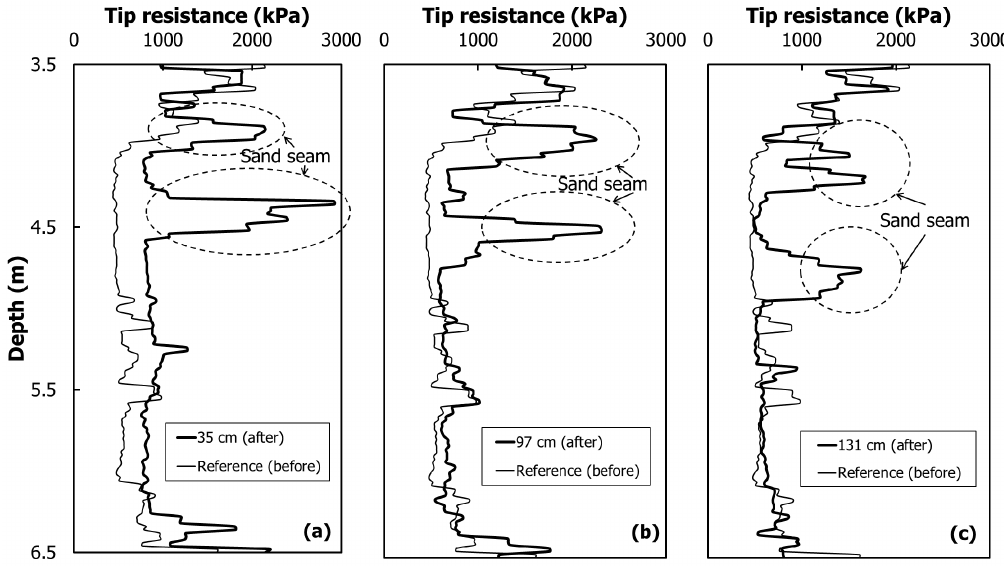
Figure 11. The variation of the tip resistance due to ground heating using an electric heat pipe (Case 4), ( a ) a point 35 cm in the horizontal direction; ( b ) 97 cm; ( c ) 131 cm.